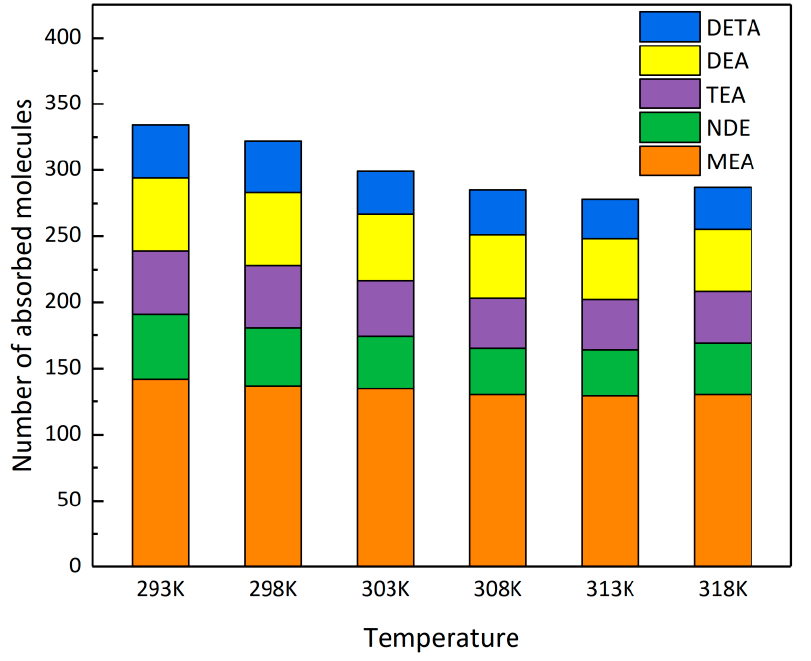
Figure 6. Adsorption quantity at a different temperature.